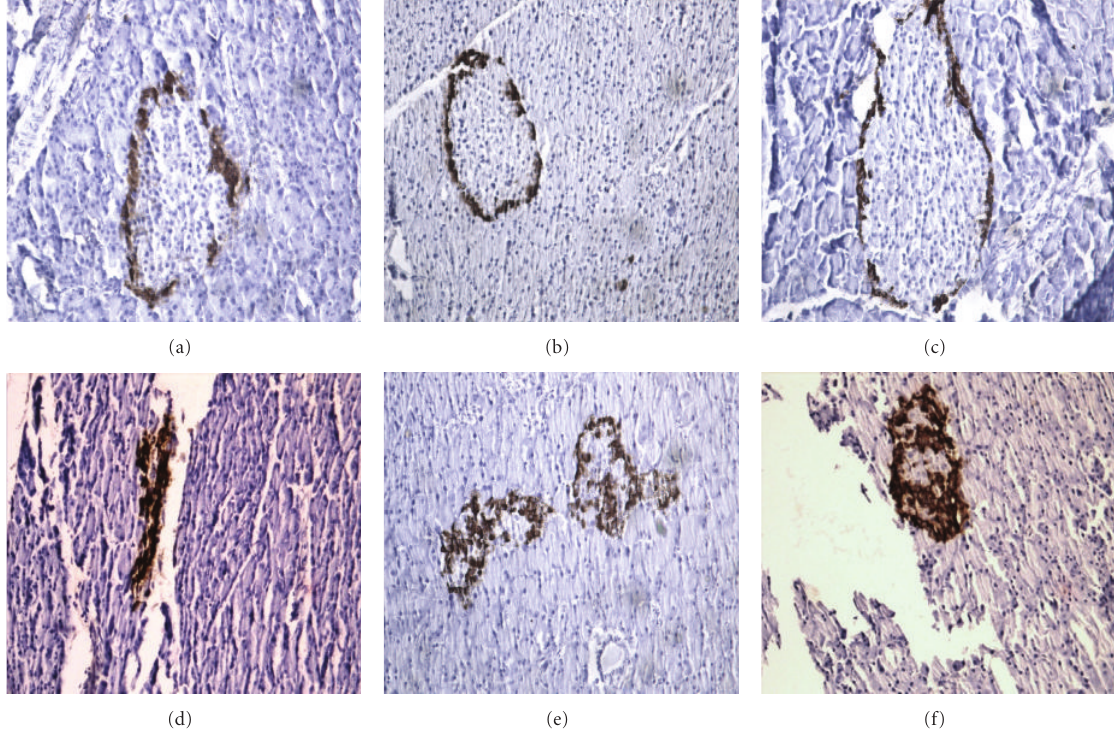
Figure 7: Immunodetection of glucagon by the ABC-DAB technique in NF (a, d), IF (b, e), and CR (c, f) control (a, b, c) and STZ (d, e, f)